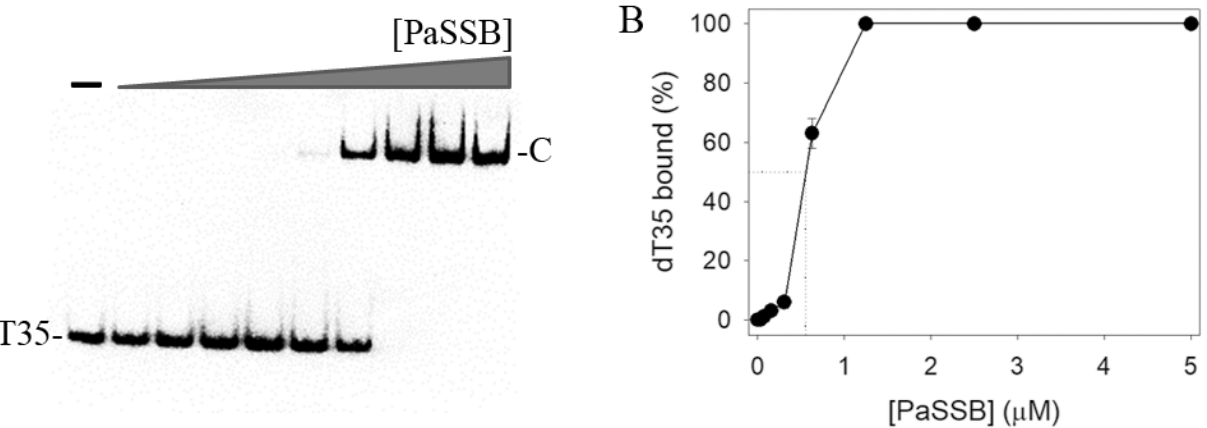
Figure 2 . EMSA of PaSSB. ( A ) Purified PaSSB (0, 19, 37, 77, 155, 310, 630, 1250, 2500, and 5000 nM) was incubated with biotin ‐ labeled dT35 at 37 °C for 60 min. ( B ) The titration curve. The [Protein] 50 value of PaSSB was determined using an EMSA.